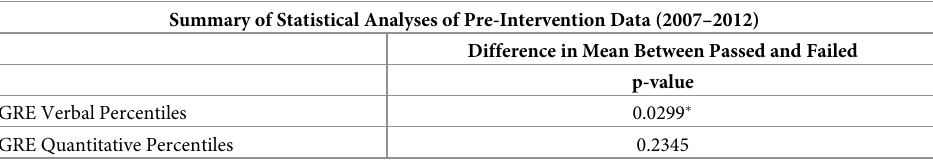
Table 7 displays the p-value from the Mann-Whitney test regarding the difference in mean GRE percentiles between students who passed or failed the candidacy exam. Data analyzed showed a significant difference in average Verbal GRE percentile between candidacy exam results with a p-value of 0.0299.